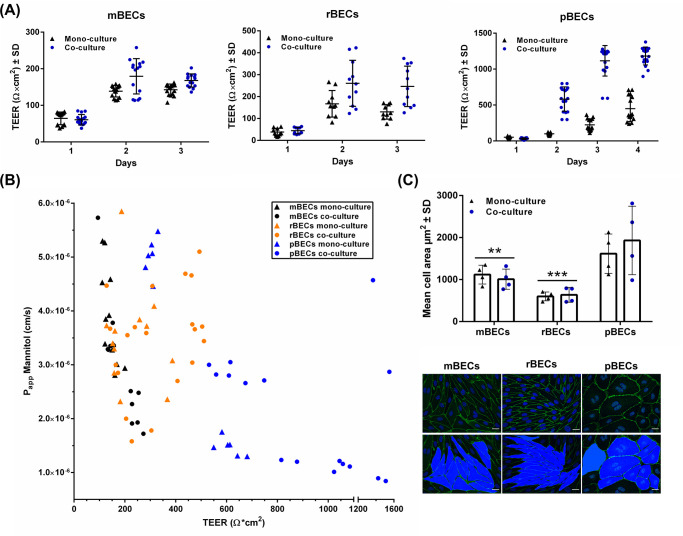
Evaluation of the blood-brain barrier integrity.(A) The transendothelial electrical resistance (TEER) (Ω*cm2) of mouse, rat, and porcine brain capillary endothelial cells (mBECs, rBECs, pBECs) cultured in mono-culture (black triangles) and co-culture with astrocytes (blue circles). Co-culturing the BECs with astrocytes causes an increase in TEER compared to mono-cultured BECs. Each triangle or circle represents an individual culture insert showing a great variation in TEER across the inserts with identical culture conditions. Both mBECs and rBECs show a rapid increase in TEER after induction (day 1), peaking around day two to three, oppositely to pBECs, which have a slower increase in TEER peaking around day four. The data are illustrated as mean ± standard deviation (SD) (mBECs n = 15, rBECs n = 10–11, and pBECs n = 15–18). (B) The functional barrier integrity of the BECs was additionally evaluated by calculating the apparent permeability (Papp) of [3H]-D-Mannitol plotted against TEER across mBECs (black), rBECs (orange), and pBECs (blue) cultured in mono-culture (triangles) or co-culture (circles). The higher the TEER, the lower the Papp; however, in the TEER range of 150–650 Ω*cm2 only small differences in the Papp are observed. mBECs n = 12, rBECs n = 12, and pBECs n = 12–16 for each culturing condition. (C) Quantification of cell area of mBECs, rBECs, and pBECs cultured in mono- and in co-culture. pBECs are significantly larger than both mBECs (p = **) and rBECs (p = ***), and co-culturing the BECs does not affect the cell size. The bottom panel shows representative images of how the area of the cells was quantified. Scalebar = 20μM. To analyze the difference in size between mono- and co-cultured BECs within the same species and to compare differences in size between species, a two-way ANOVA with Tukey’s multiple comparisons post hoc test was used. ** p< 0.01, *** p< 0.001. Data are depicted as mean cell area μm2 ± SD (n = 4).